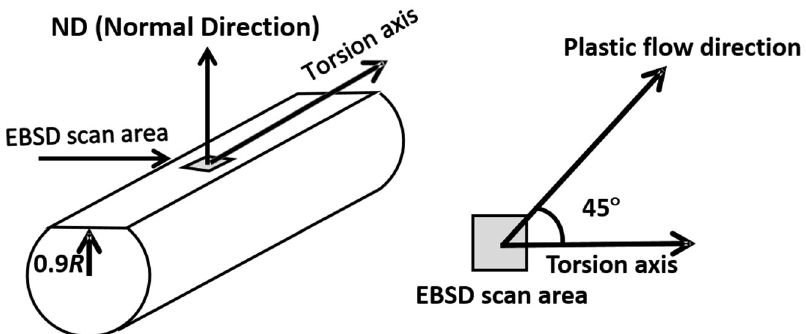
Figure 1. Experimental setup for the EBSD (Electron Back-Scatter Diffraction) scan acquisition and area of analysis in the torsion specimens.